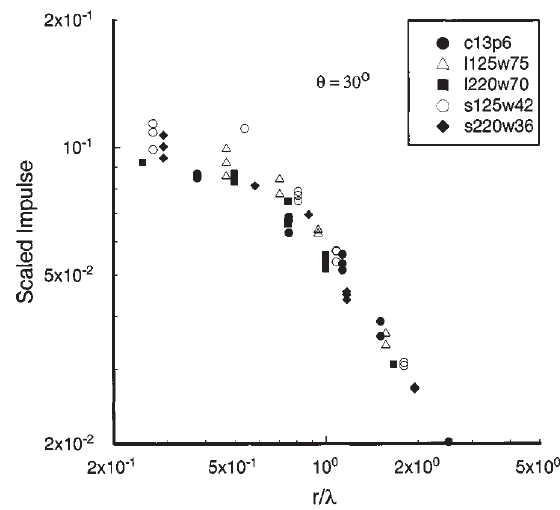
Fig. 7. Scaled impulse versus r/λ for θ = 30 ◦